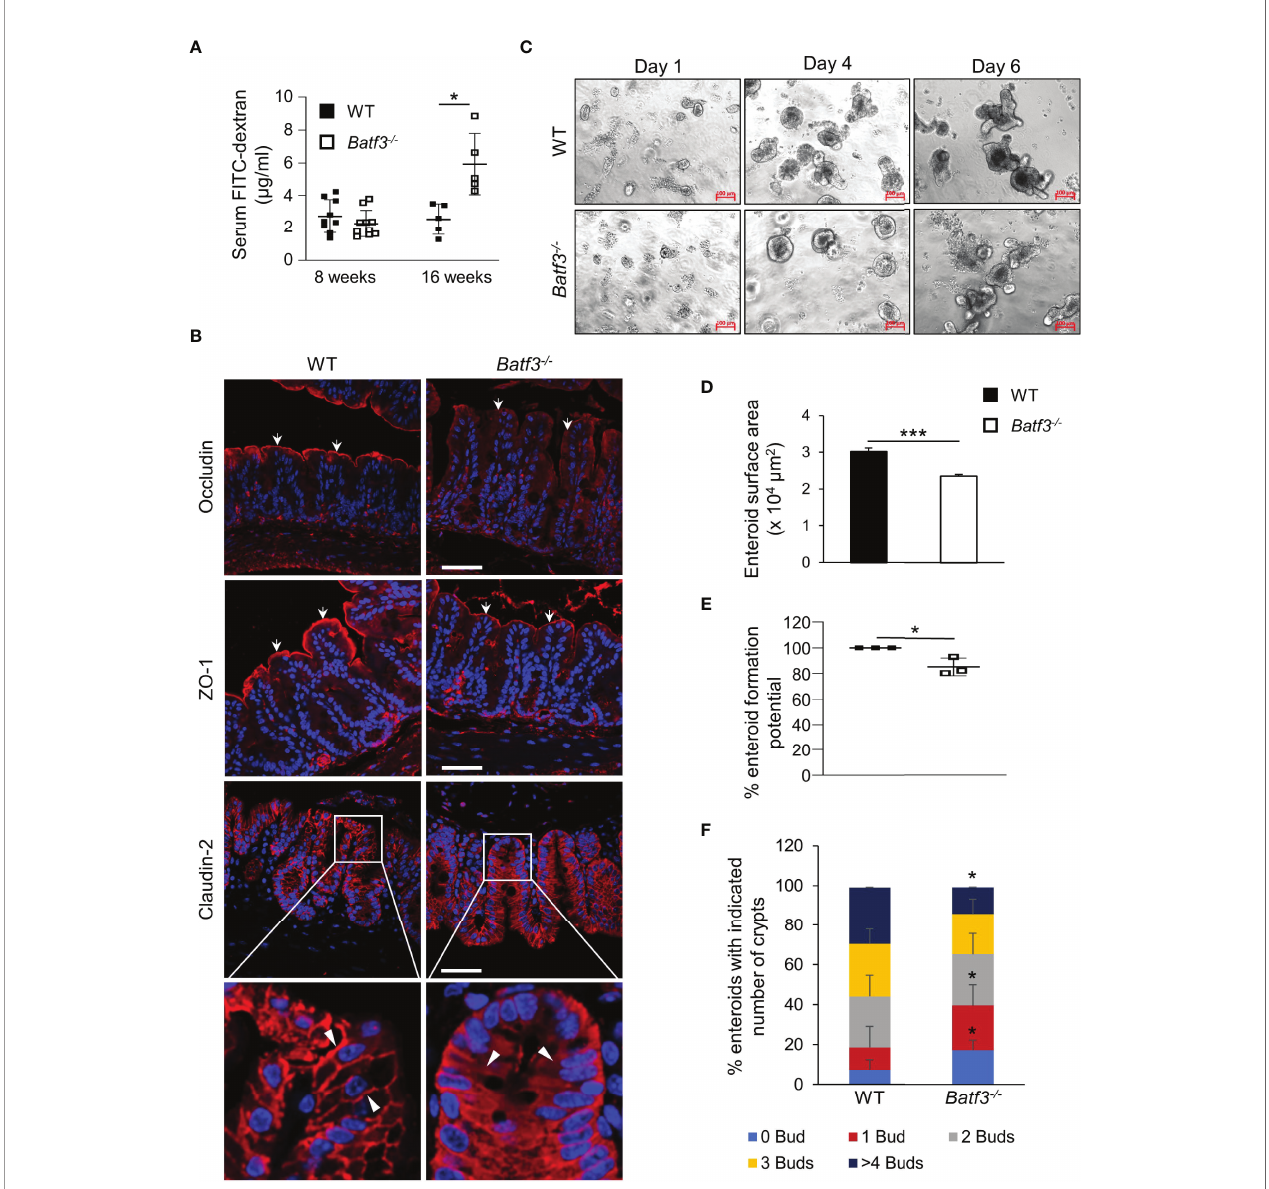
FIGURE 2 | BATF3-de fi ciency leads to a loss of intestinal barrier integrity. (A) Intestinal permeability assay measuring serum concentration of FITC-labeled dextran in WT and Batf3 -/- mice 3 h post FITC-dextran gavage at 8 and 16 weeks of age (8 weeks, n = 9-10/genotype; 16 weeks, n = 5/genotype). (B) Representative cecal immuno fl uorescence images of Occludin, ZO-1, Claudin-2 (all red), counterstained with DAPI (blue) at 16 weeks of age (Scale bar, 50 m m). White arrows indicate apical expression of Occludin, and ZO-1 on the intestinal epithelial layer. White arrow heads indicate membrane expression of Claudin-2 in WT (left panel), and cytosolic expression in Batf3 -/- mice (right panel). (C) Representative phase contrast images of the ileal enteroids developed from WT and Batf3 -/- mice captured on days 1, 4, and 6 using inverted microscope. Three independent experiments were performed (n=3/group) (Scale bar, 100 µm). (D – F) Characterization of enteroids on day 6 for (D) enteroid surface area, (E) enteroid formation potential, and (F) de novo crypt formation (budding). Three independent experiments were performed (n = 60-100 enteroids/genotype/experiments). Data are represented as means ± SD (A) or ± SEM (D, E) . Statistical signi fi cance was determined by unpaired t -test (for analyzing enteroid surface area, and % enteroid formation potential) or by Mann-Whitney-U test (for de novo crypt formation, and FITC-dextran assay). * p < 0.05, *** p <